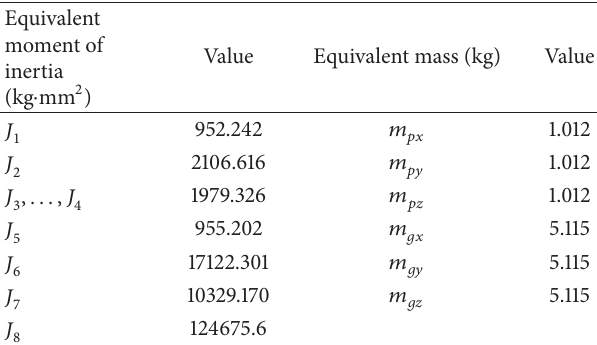
Table 4: Values of the equivalent moment of inertia and equivalent